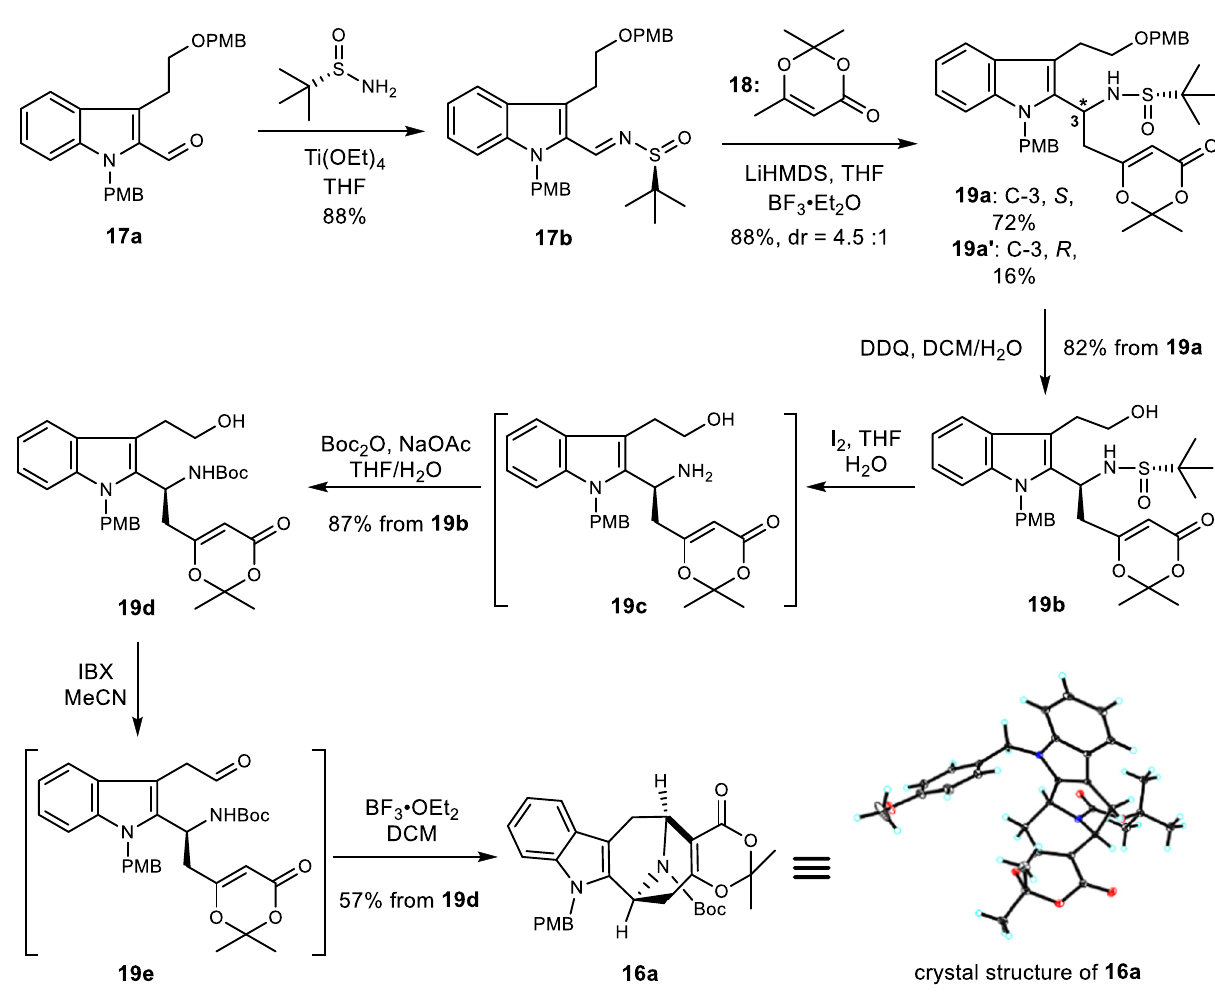
Fig. 3 Gram-scale synthesis of common intermediate 16a. The key transformations to access the common intermediate 16a include a vinylogous Mannich reaction of lithium dienolate 18 , and a Lewis acid mediated Mannich type cyclization of 19e . Ac acetyl, Boc t -butoxycarbonyl, DCM dichloromethane, DDQ 2,3-dichloro-5,6-dicyano-1,4-benzoquinone, IBX o -iodoxybenzoic acid, LiHMDS lithium bis(trimethylsilyl)amide, PMB p -methoxybenzyl, THF